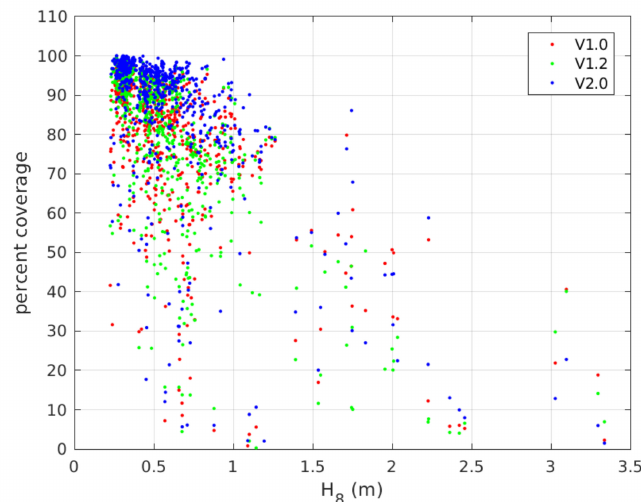
Figure 13. Percentage of successful coverage for sub-aqueous pixels versus significant wave height at the 8 m array for each of the three versions. Versions were plotted in order from versions 1.0 through 2.0 so the results from version 2.0 (blue dots) overplot earlier